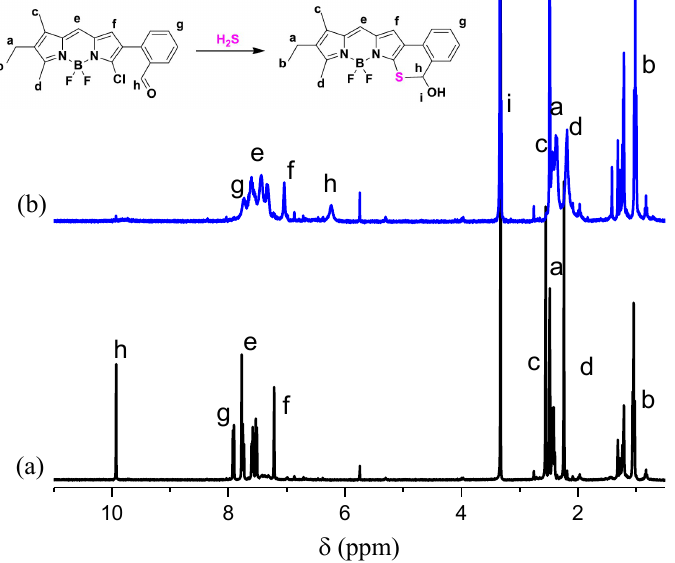
Figure 3. The 1 H-NMR titration of probe BH toward H 2 S in DMSO-d6 (400 MHz), ( a ) BH ; ( b ) BH + H 2 S.